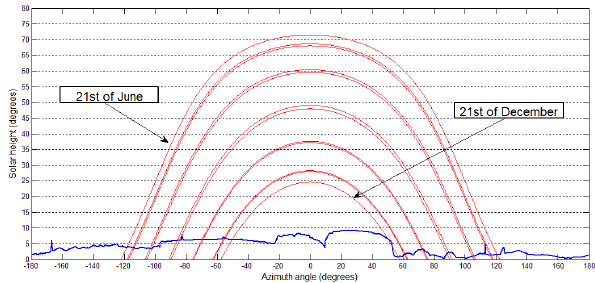
Figure 1. Solar path for the 21st of each month (red lines) and hori- zon height for each azimuth angle (blue